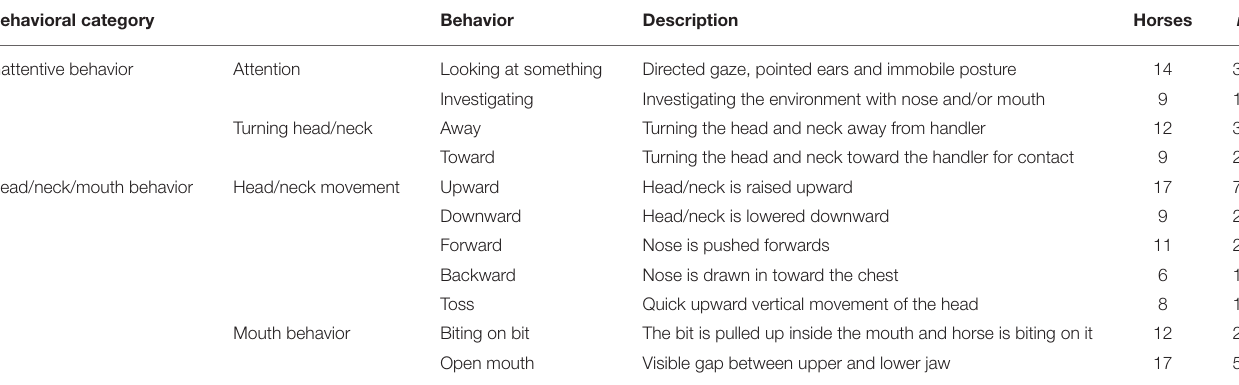
TABLE 1 | Ethogram used for behavior recording [modified after Egenvall et al. (22) and Fenner et al. (7)]. Behavioral